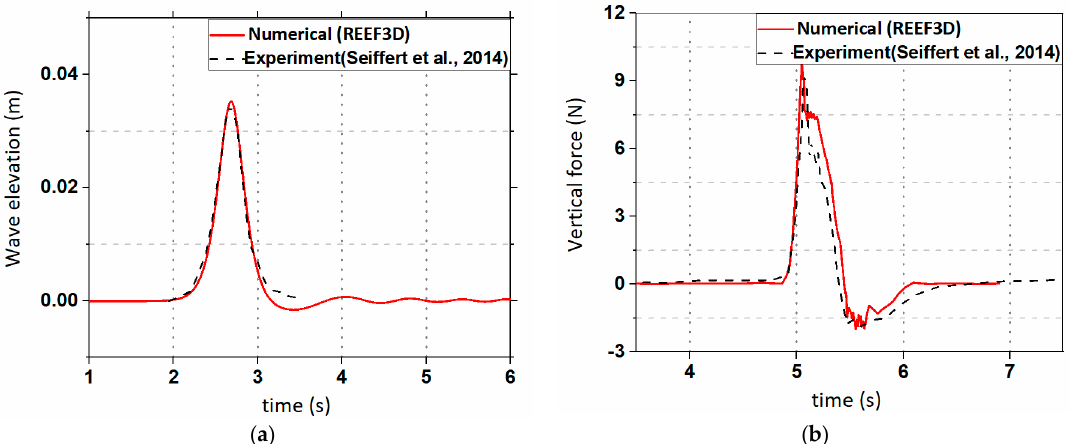
Figure 3. Comparison of wave elevation from numerical model with experimental results of Seiffert et al., 2014 ( a ) Wave elevation ( b ) Vertical impact force.